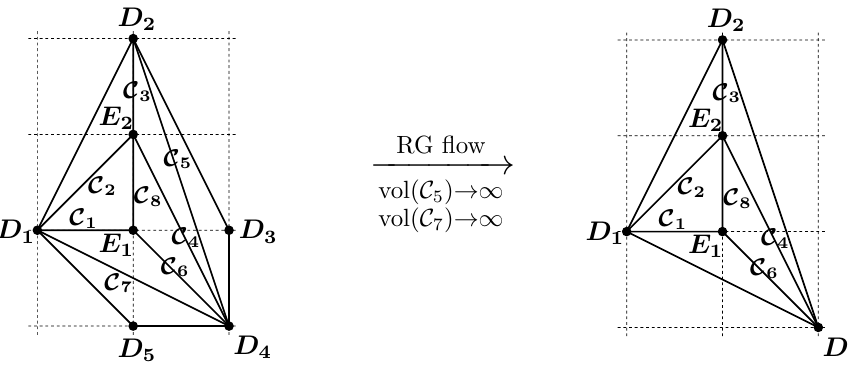
Figure 18 . Decoupling two divisors from E 22 ; 3 2 resolution (g) yields an SL(2 ; Z )-transformed version of the unique crepant resolution of the E 02 ; NL singularity.